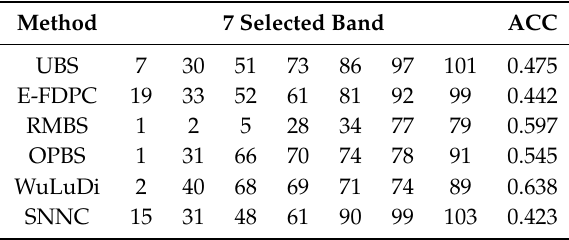
Table 3. Number of recommended bands on Pavia University data